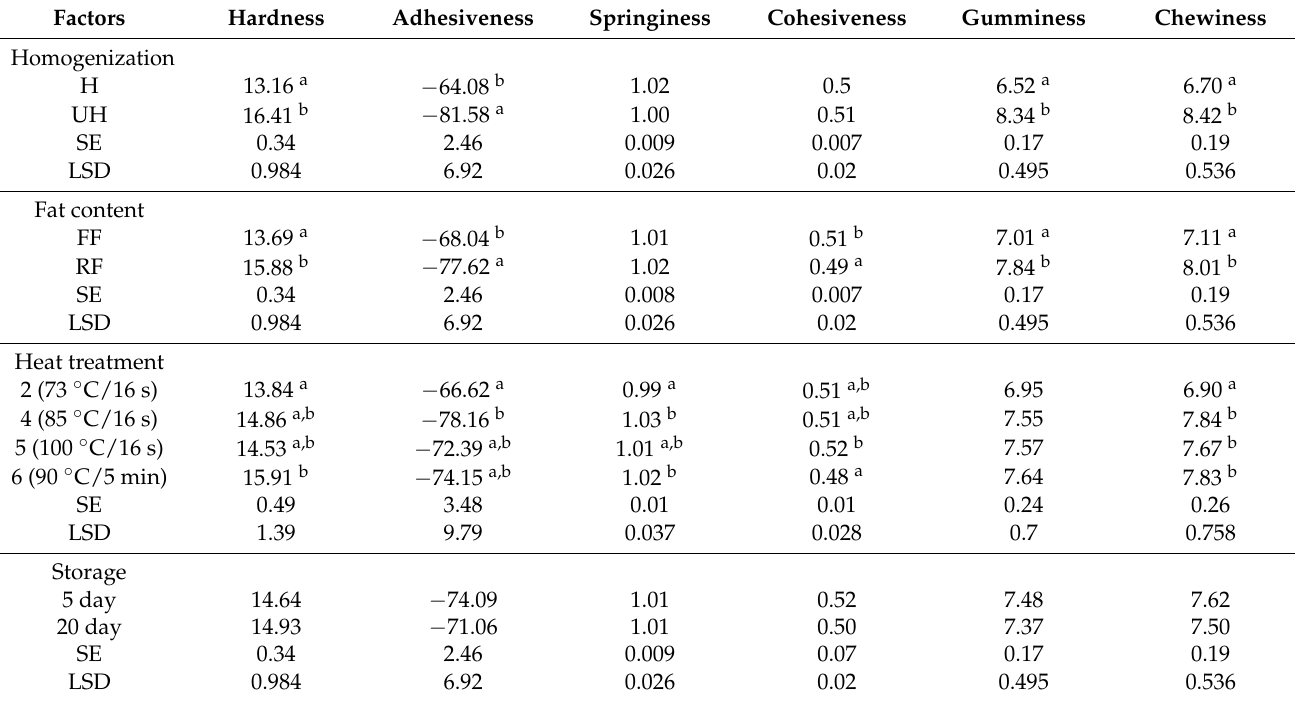
Table 4. Means of the parameters of texture profile analysis of Quark-type cheeses made from unhomogenized and homogenized full- and reduced-fat milk heated under different